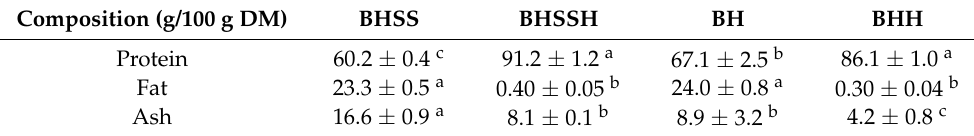
Table 1. Proximate composition of Baltic herring raw materials and hydrolysates ( n = 3). Composition (g/100 g DM)